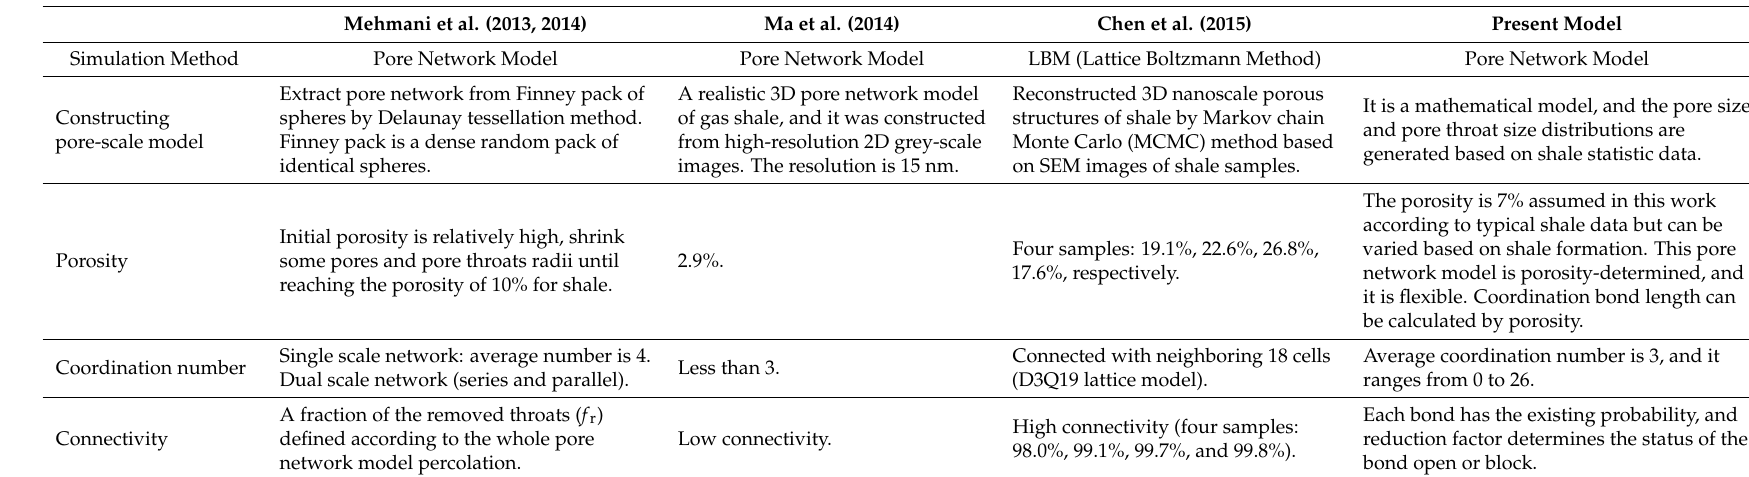
Table 1. Comparison of different pore-scale